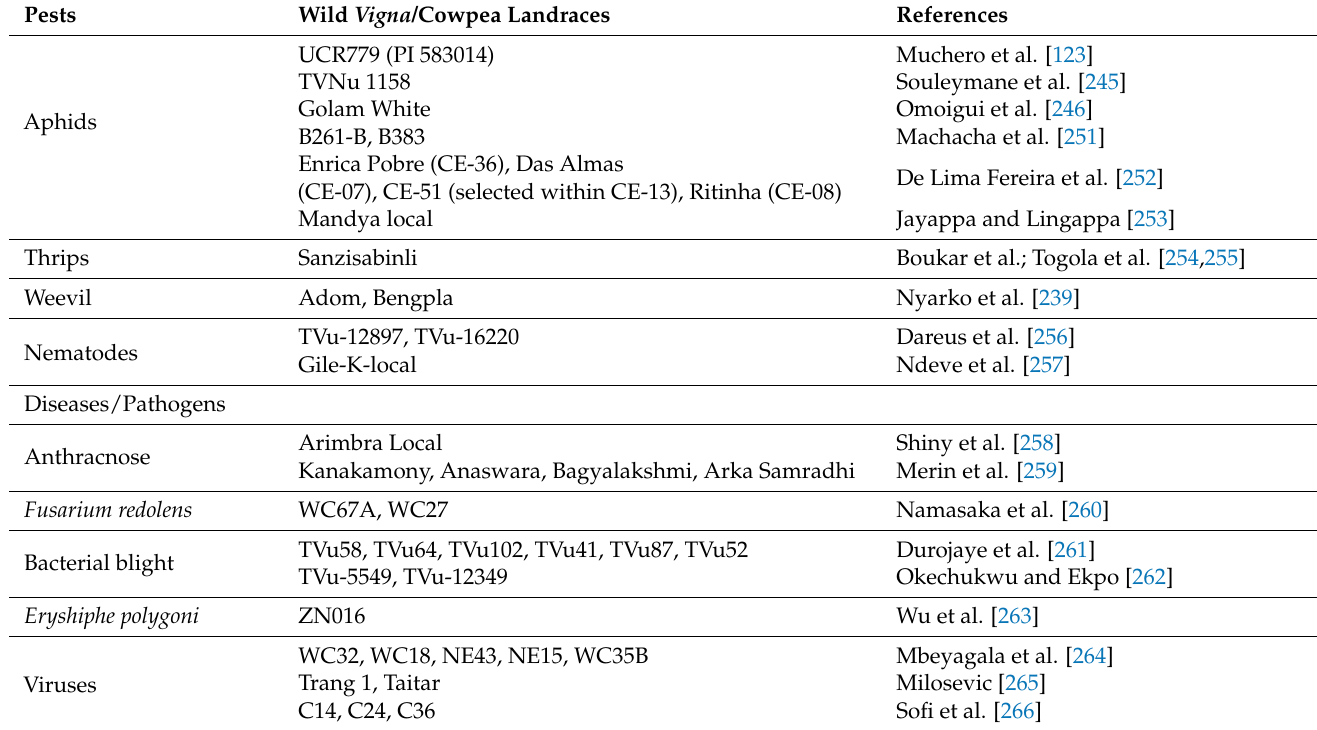
Table 5. Wild Vigna material and cowpea landraces with resistance or immunity to main pests and diseases/pathogens prevailing in